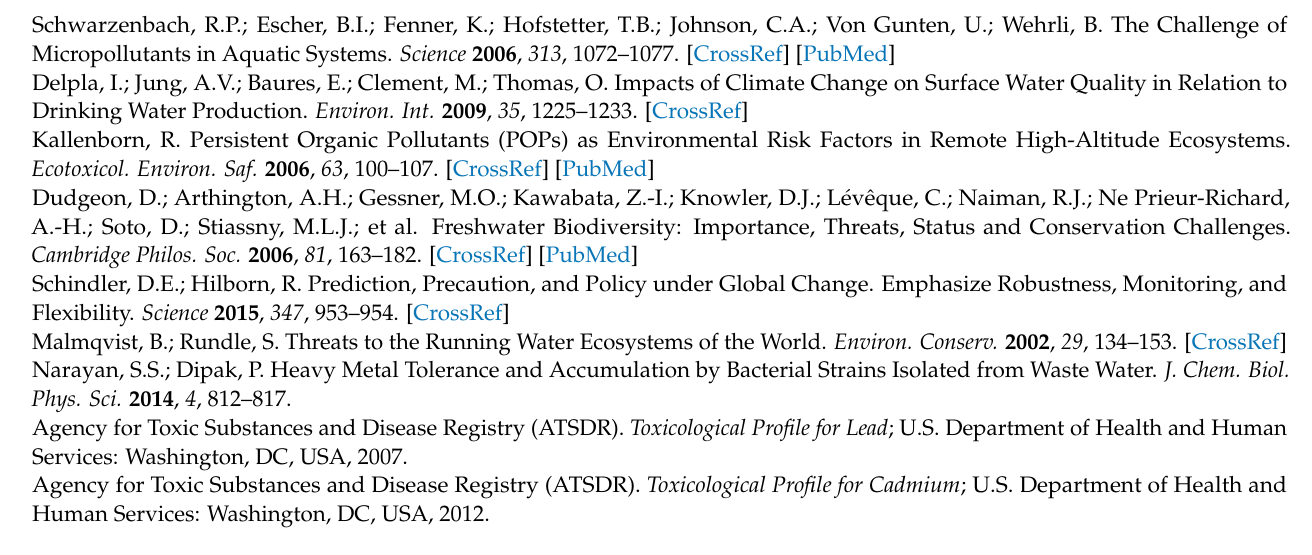
Table S2: Kinetic models used on CHIT-PAAA adsorption data, Table S3: Geographic coordinates of the collected metal-polluted water samples, Figure S1: FTIR of CHIT-PAAA before and after adsorption of Pb and Cd from 40 mg L − 1 ( a ) and 100 mg L − 1 ( b ) stock solutions, Figure S2: The effect of contact time on ( a ) Pb and ( b ) Cd sorption capacities of CHIT-PAAA, Table S4. Results of the Pb and Cd adsorption equilibrium study performed on CHIT-PAAA. (Ci = 10–100 mg L − 1 , 0.02 g material, 298 K, 600 rpm, 24 h), Figure S3. Separation factors determined for Pb ( a ) and Cd ( b ) adsorption onto CHIT-PAAA, Table S5: Results of the kinetic models applied for Pb and Cd sorption algorithms applied for ANN modeling of Pb and Cd adsorption onto CHIT-PAAA , Figure S4: Error histograms and regression plots of Pb (a,b) and Cd (c,d) ANN adsorption models generated with Levenberg–Marquardt algorithm, Table S7: Comparison between calculated and ANN